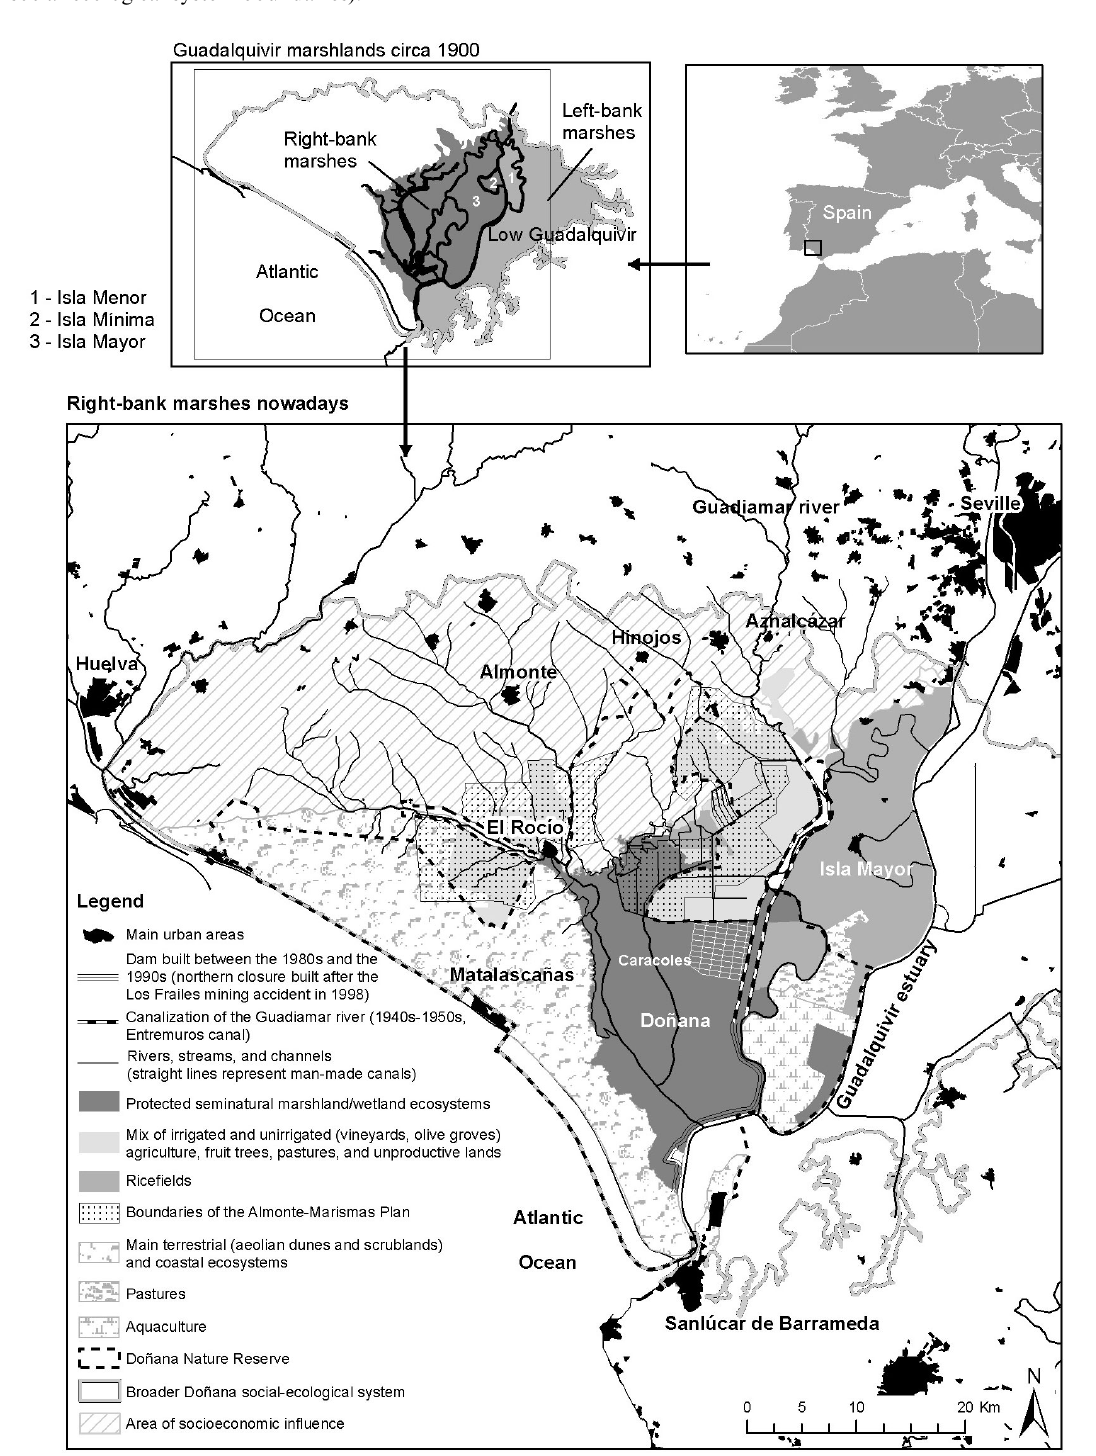
Fig. 1 . Geographical location of the Doñana region. Source: our own development from POTAD (2003), Castells et al. (1992; Almonte-Marismas Plan boundaries), and Gómez-Baggethun et al. (2012; broader Doñana social-ecological system